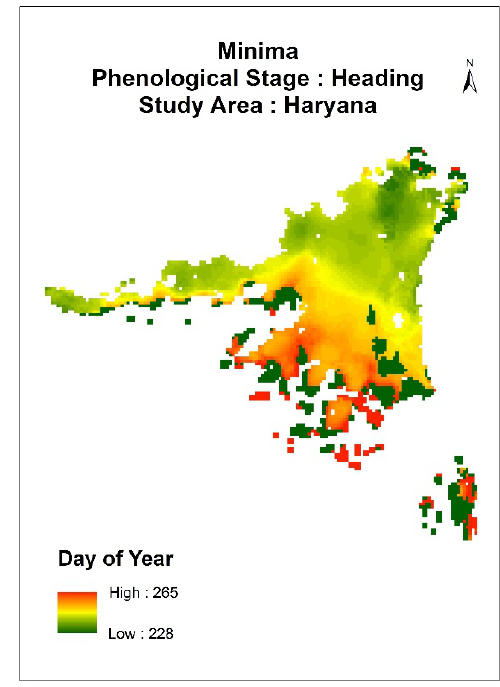
Figure 7: Heading stage of Rice for Haryana derived from ScatSat Data